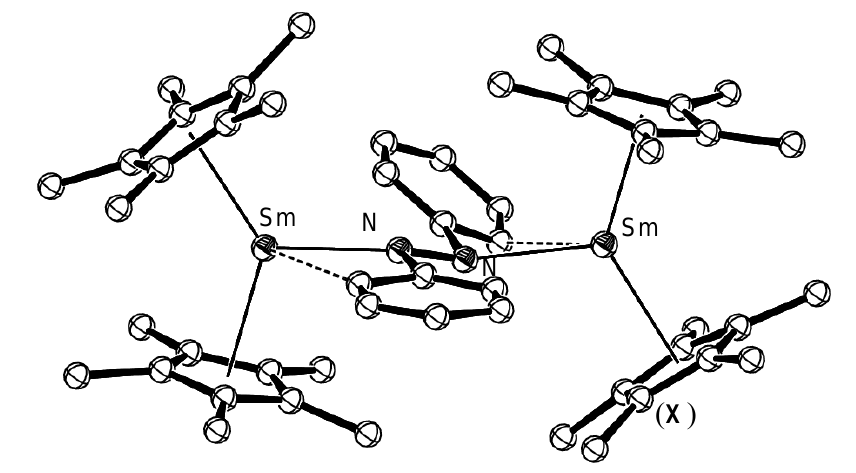
Figure 5. Molecular structure of [{(C from CCDC obtained coordinates. Atoms of arbitrary size. H atoms are omitted for clarity